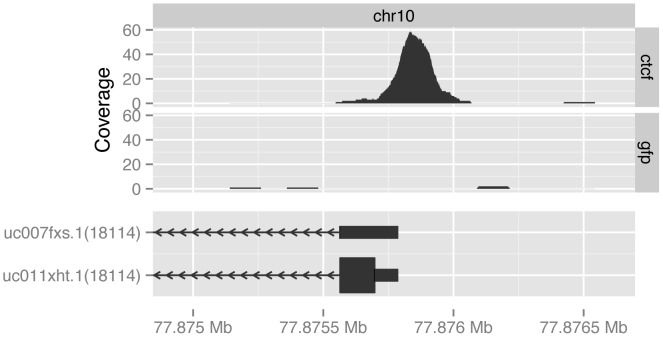
Visualization of the coverage of bases by GFP- and CTCF-bound fragments (top) in the context of part of the gene model for Rrp1, Entrez gene 18114 (bottom).